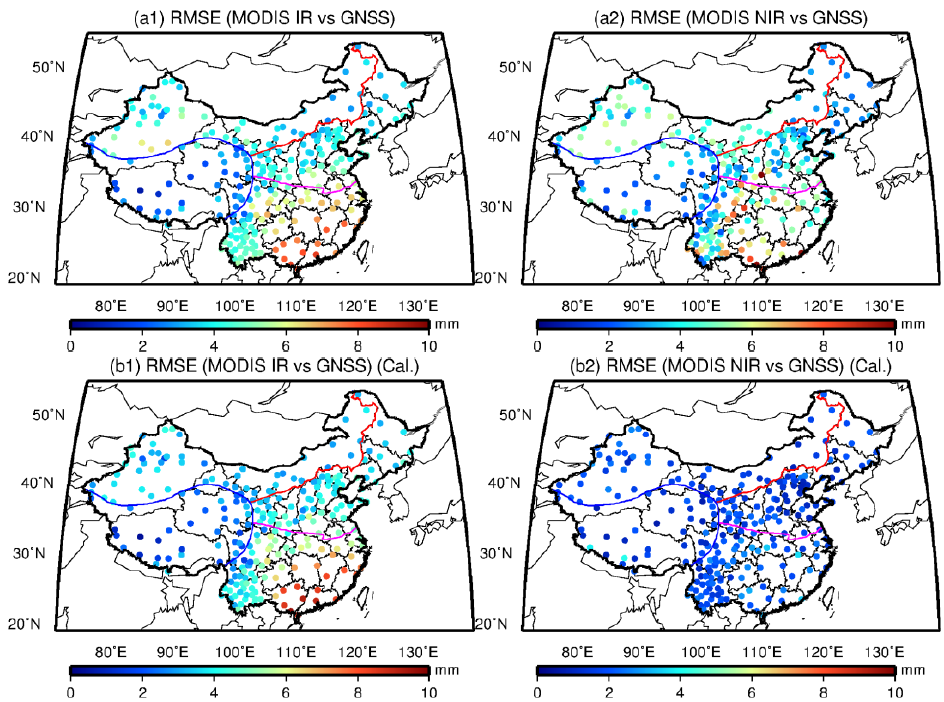
Figure 8. RMSE distribution of paired stations between MODIS and GNSS over the period of 2011–2017, where the first row ( a1 , a2 ) is the RMSE of MODIS IR/NIR PWV without calibration, and the second row ( b1 , b2 ) is the values with calibration using GNSS PWV.